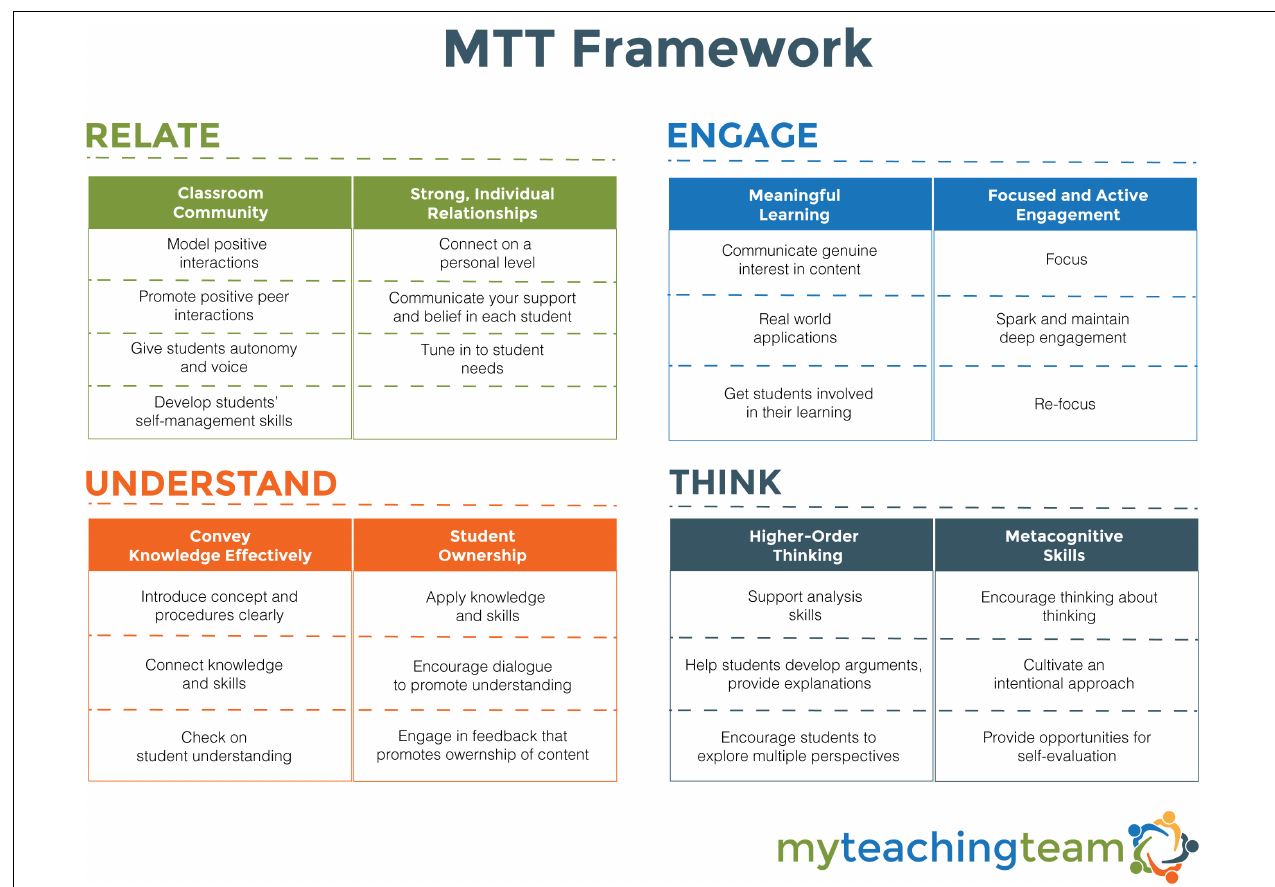
FIGURE 1 | MTT framework